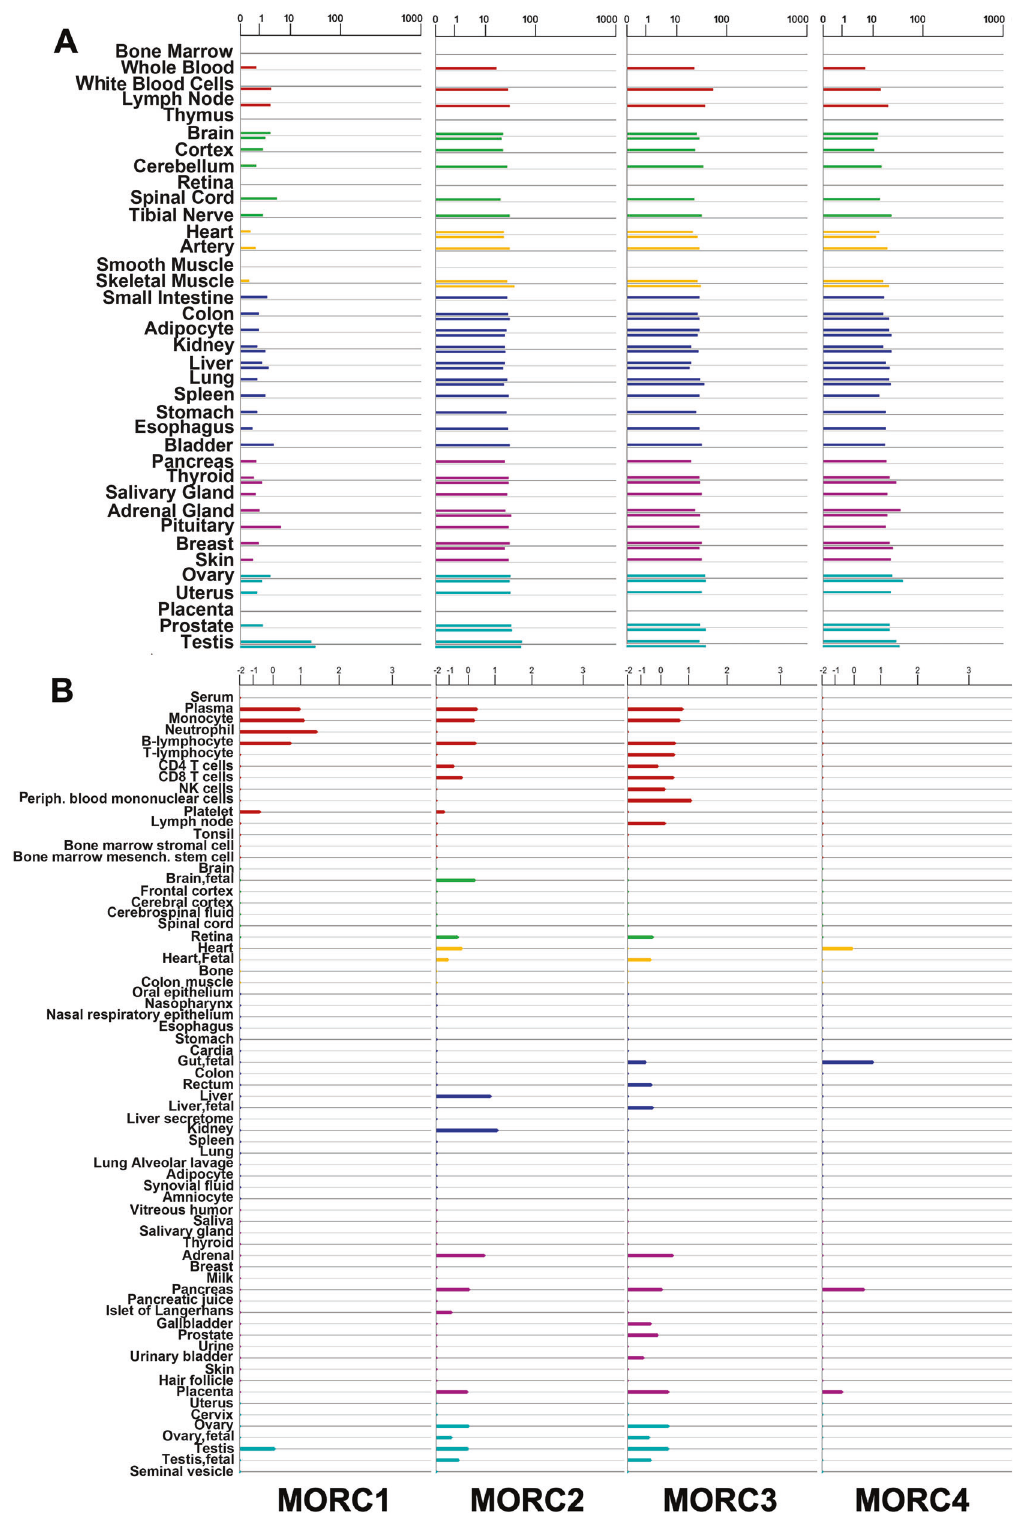
Fig. 2 MORC family expression in normal human tissues. A mRNA expression of MORC family in normal tissues from GTEx; B protein expression in normal tissues and cell lines from Proteomics DB (https://www.genecards.org).